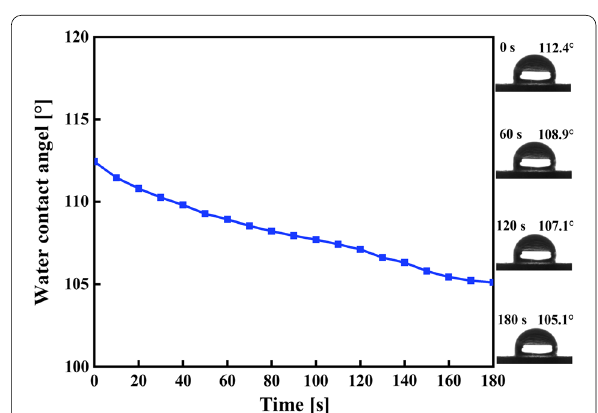
Fig. 7 Water contact angle of PDMS synthetic leather coating over time